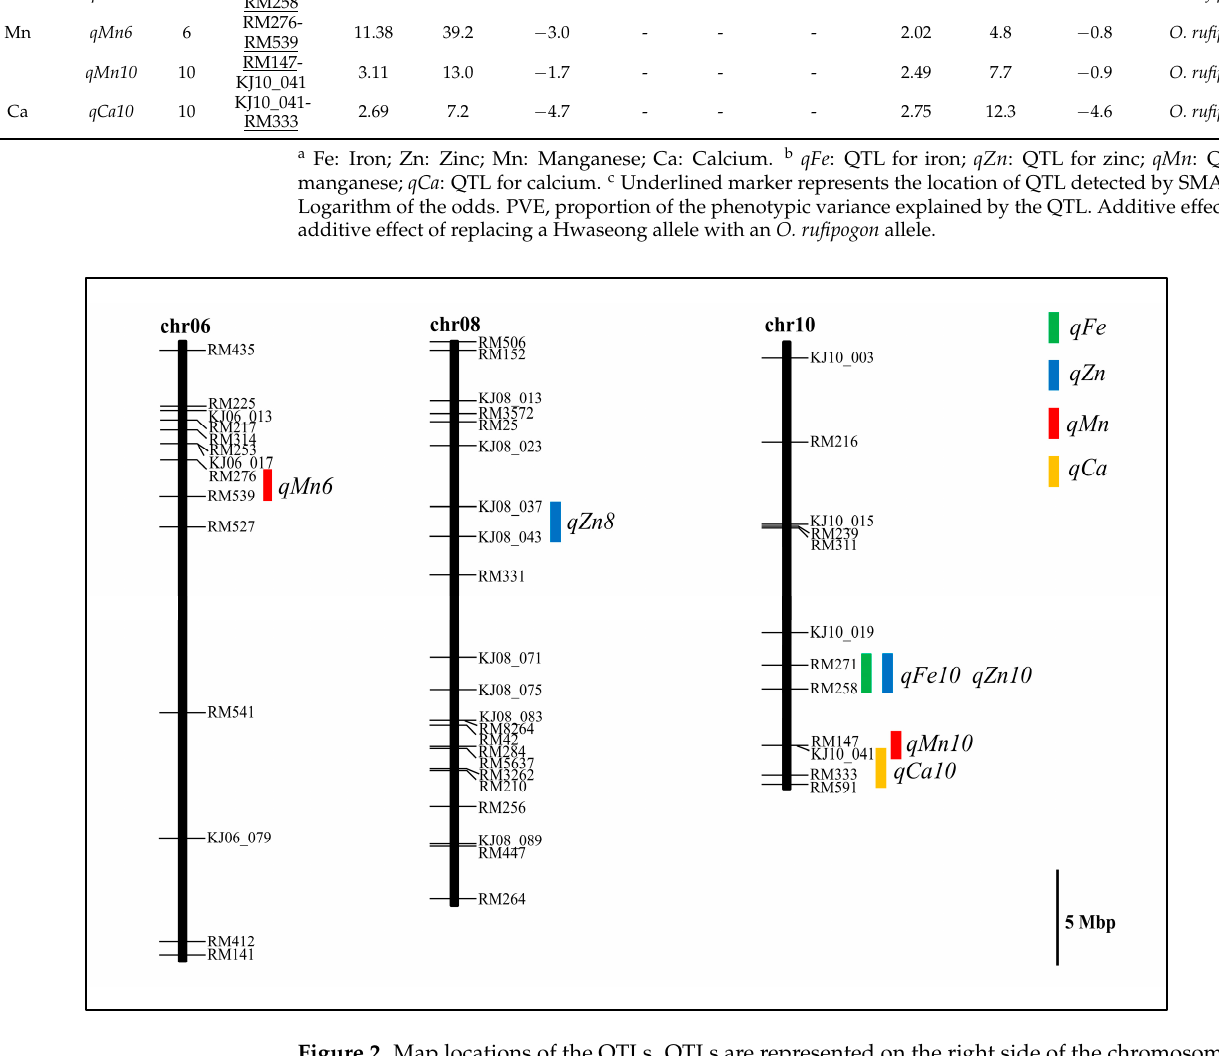
Figure 2. Map locations of the QTLs. QTLs are represented on the right side of the chromosome. qFe : QTL for iron; qZn : QTL for zinc; qMn : QTL for manganese; qCa : QTL for Table 2. QTLs for grain mineral element contents detected in 96 ILs.